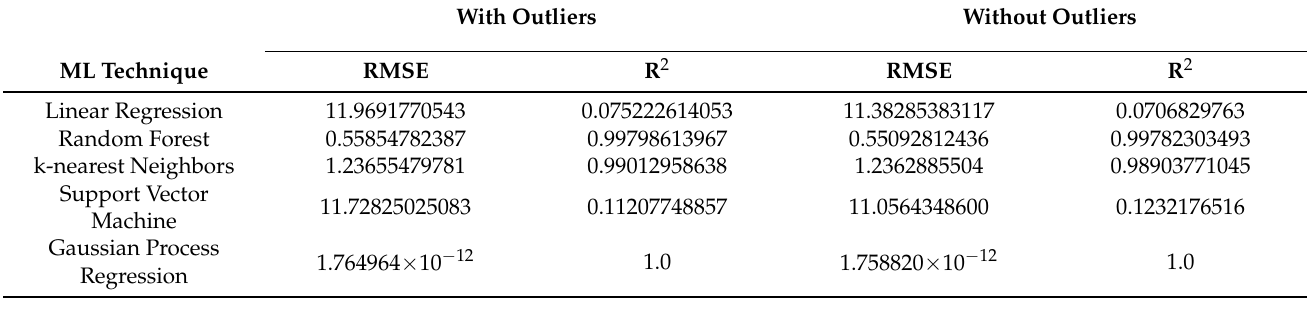
Table 16. Humidity results for the suspended particulate matter measuring device.